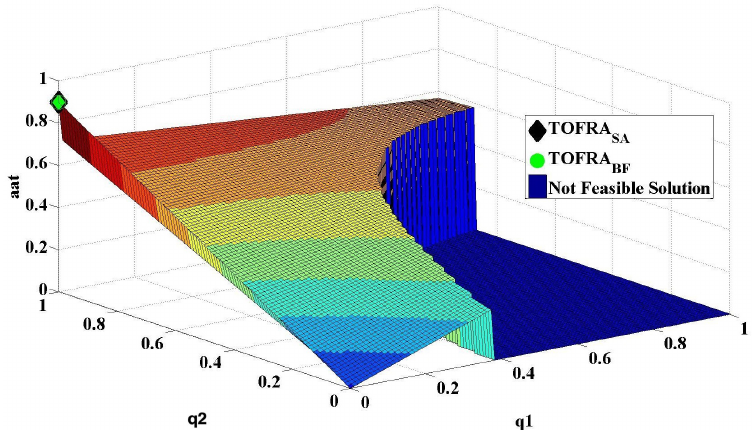
Figure 10. Simulated annealing vs. brute force, test case 2: Topology = 1, γ = 2.0, Interference handling: